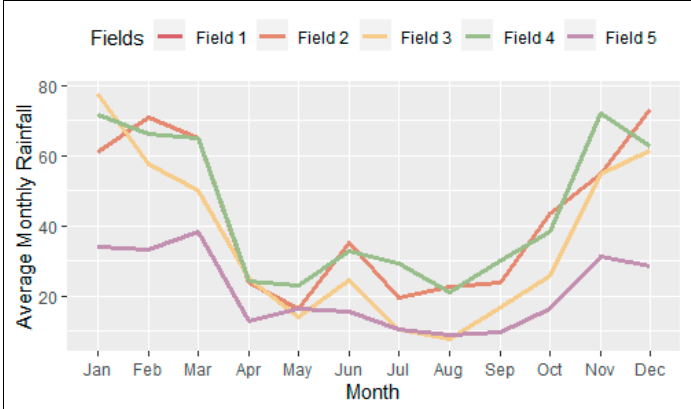
Figure 2. Average monthly rainfall, in mm. Fields 1 and 2 are close to each other and have the same climate data.